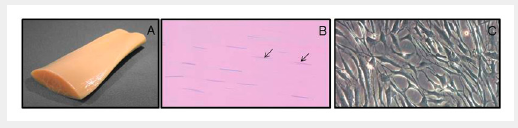
Figure 1 Tendon structure, histology and cell culture. Ultrastructure of tendon showing longitudinal fibres and histological sections stained with haematoxylin and eosin depicting extracellular matrix colored in pink (~80% composition) and cellular components mainly with tenocytes stained in blue (~20% composition)(horse tendon for illustration). Primary cultures from tissue can be developed by culturing cells in minimal medium (DMEM + 10% FBS + 1% glutamine) for approximately 1 week in a monolayer culture to provide “fibroblast-like” pure tenocyte populations (human progenitor tenocytes).